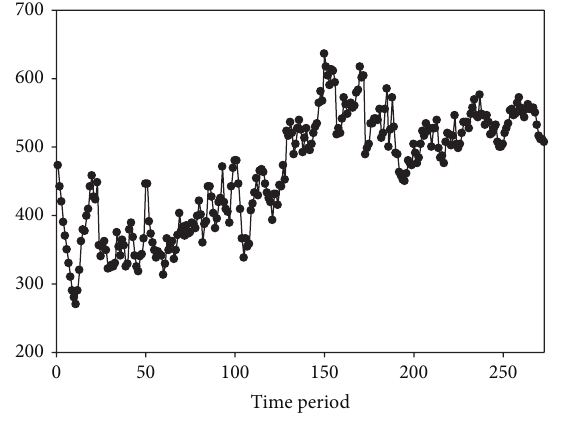
Figure 3: Water flow time series.